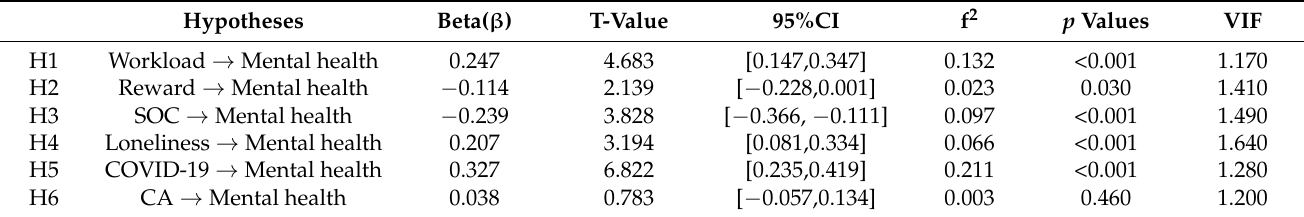
Table 4. Hypothesis testing of mental health model in foreign care workers (n =